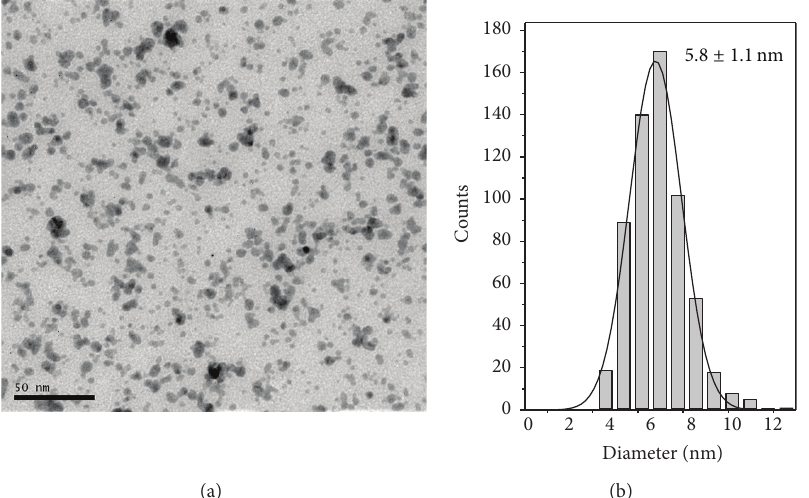
Figure 2: (a) TEM micrographs showing the Pd(0) nanoparticles solution observed at 120kV. (b) Histogram illustrating the particle size distribution.